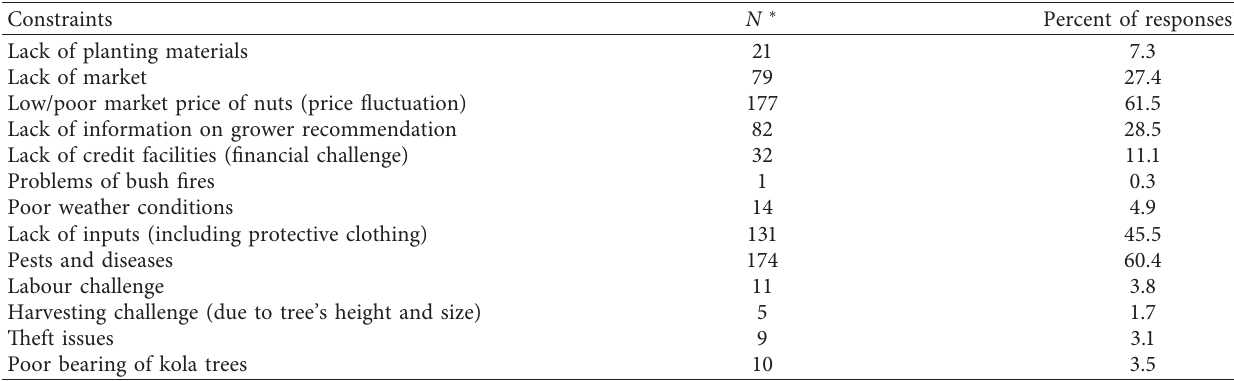
Figure 7: (a) A disease referred to as “Turu” by kola farmers caused by kola nut weevil. (b) A disease referred to as “Jerry” by kola farmers in Nkawkaw. Table 7: Major constraints to kola production.